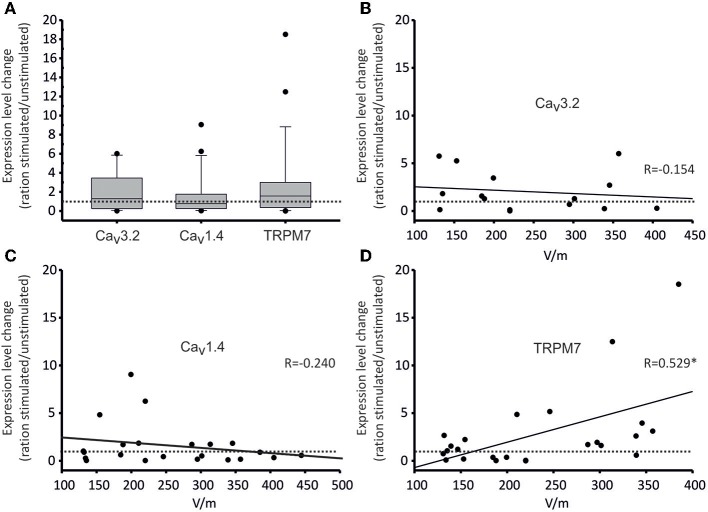
Gene expression of selected calcium channels under DC-stimulation. Gene expression changes are given as ratios of stimulated/non-stimulated cell cultures (as values on all ordinates). (A) Box plot of all expression ratios for Cav3.2, Cav1.4, and TRPM7 channels displaying 10, 25, 75, and 90 percentiles, as well as medians (Cav3.2: 1.288, Cav1.4: 0.761, TRPM7: 1.572) comparing stimulated/non-stimulated osteoblast cultures irrespective of stimulation intensity. The dotted line represents a ratio of 1, i.e., no change. Both Cav3.2 and TRPM7 expressions were thus increased on average, while the expression of Cav1.4 was decreased. Over the whole range of stimulation voltages, however, these changes were not significant. (B–D) Dot plots of correlations of expression ratios of Cav3.2 (B), Cav1.4 (C) and TRPM7 (D) channels and voltages of DC-stimulation. Each dot represents one experiment. Again, the dotted line represents a ratio of 1, i.e., no change. Continuous lines show linear regressions; the corresponding regression coefficients R are given in the insets. For TRPM7, the channel expression increased significantly (* denotes significant regression) with increasing stimulation strength (R = 0.529, p = 0.0079).